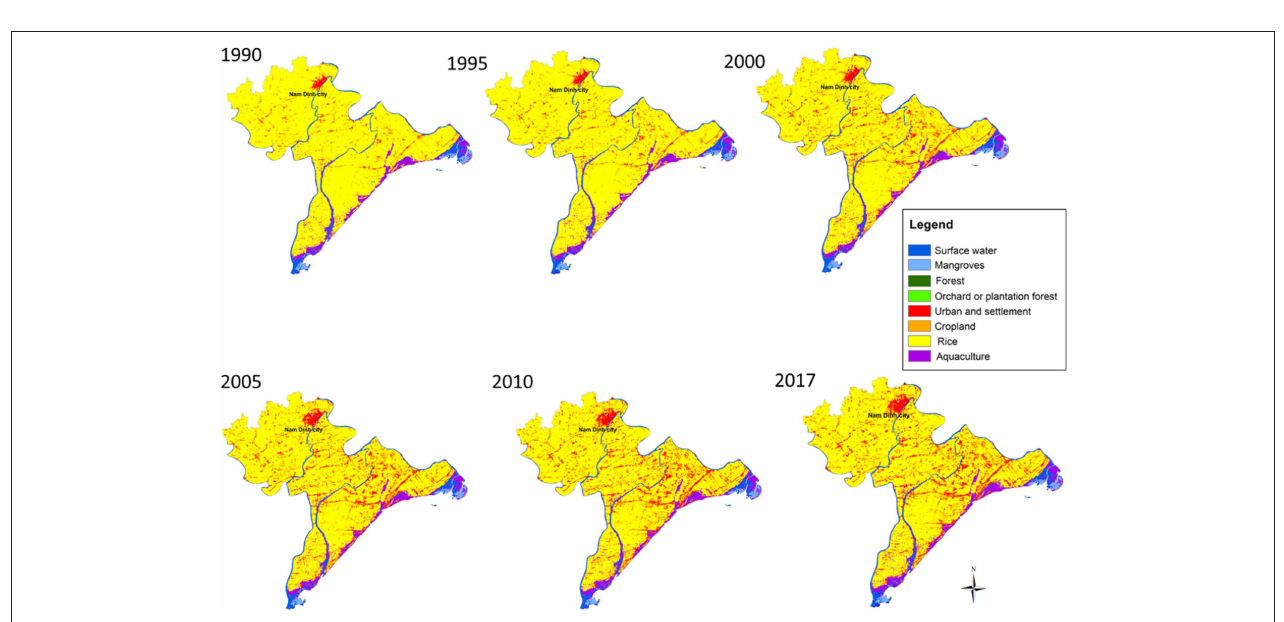
FIGURE 10 | Land cover change in Nam Dinh with 5 year intervals from 1990 to 2017. The statistics can be found in Supplementary Table 6